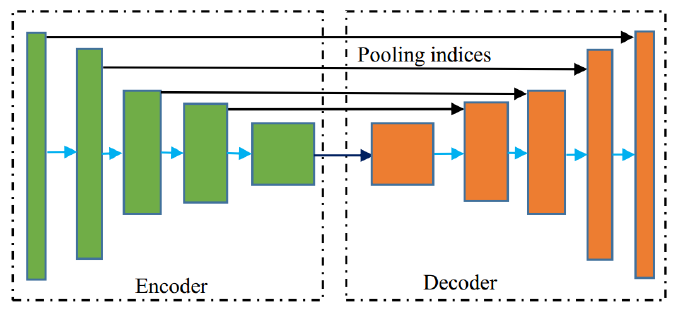
Figure 2. SegNet network structure. Note that the figure is designed according to Reference [29].